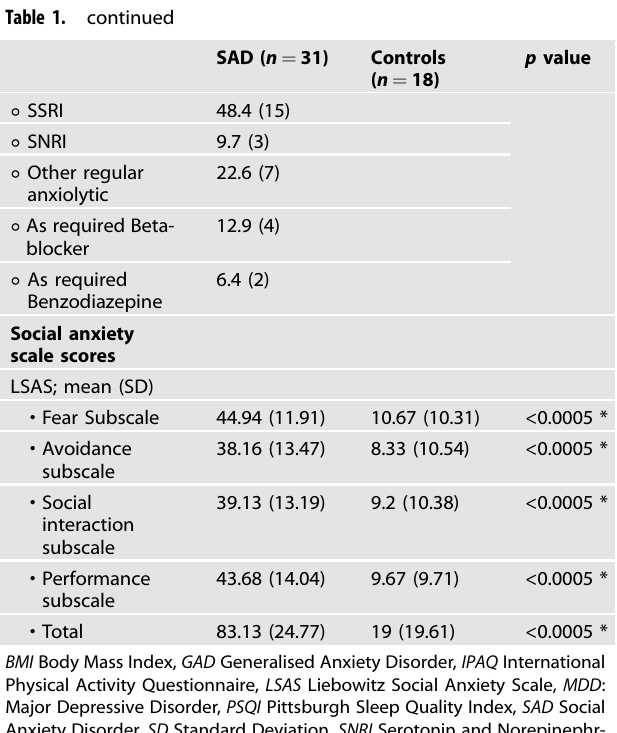
the SAD group had higher BMI scores compared to controls (t(46) = 2.65, p = 0.01). SAD patients had signi fi cantly lower exercise levels than controls, based on mean IPAQ scores (t(45) = − 2.125, p = 0.04), the difference when looking at exercise categories being at the level of a trend (X 2 (2) = 5.822, p = 0.054). Almost three-quarters (74.2%) of SAD patients had a past history of MDD and 35.5% had a comorbid secondary anxiety disorder. Just over two-thirds (67.7%) of patients were taking psychotropic medication. The majority of these patients were prescribed an SSRI (48.4%) (8 taking Escitalopram, 2 taking Vortioxetine, 2 taking Sertraline, 1 taking Citalopram, 1 taking Paroxetine, 1 taking Fluoxetine) or SNRI (9.7%) (3 taking Venlafaxine) with 22.6% ( n = 7) taking an alternative regular